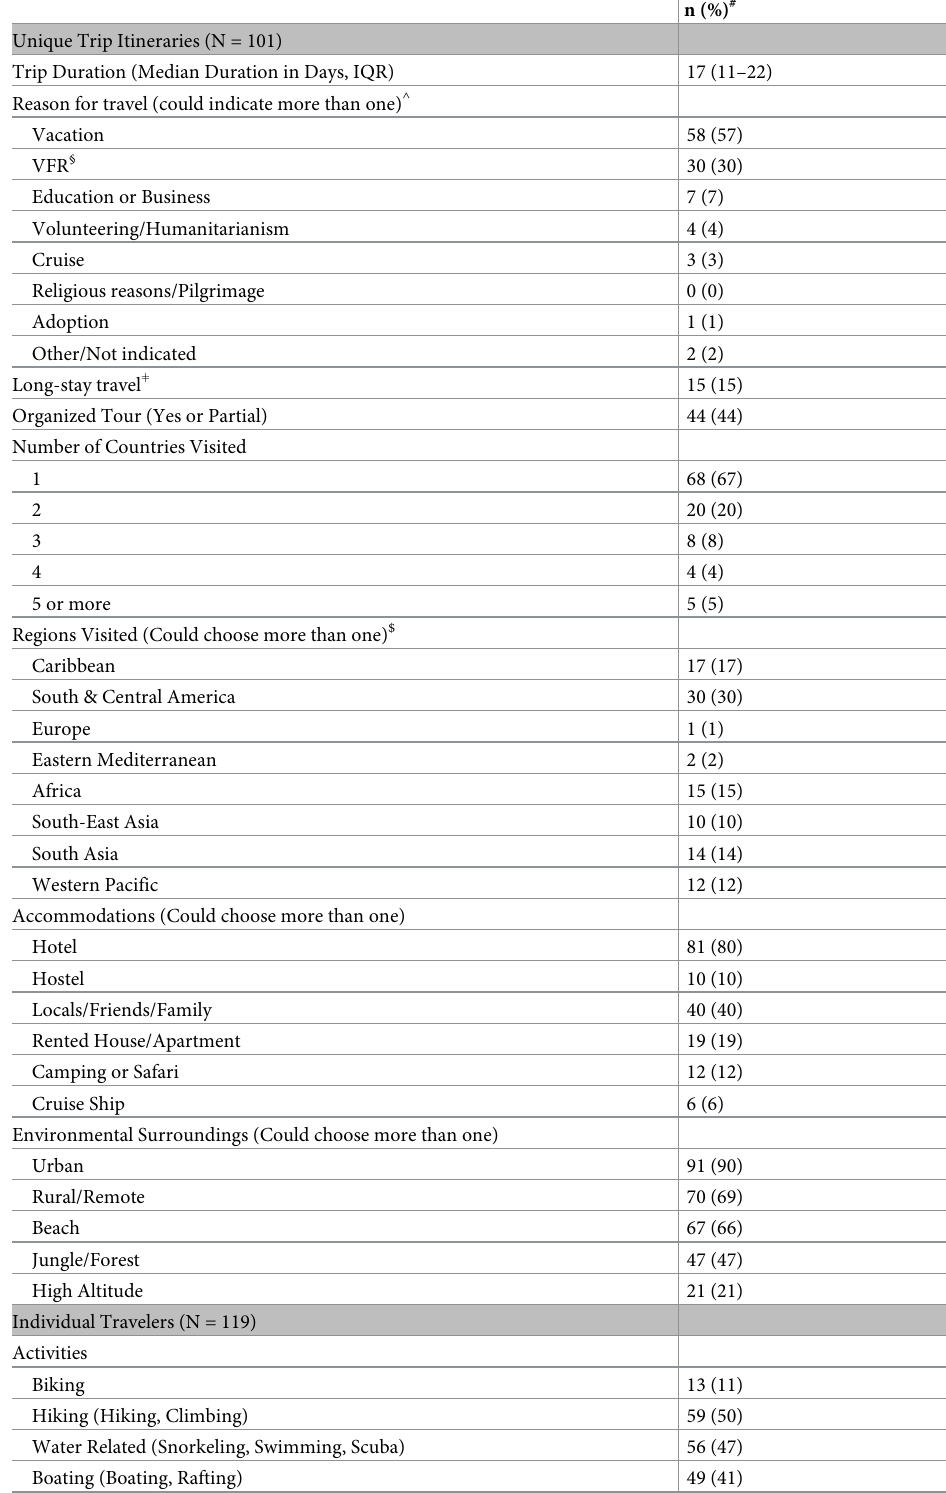
Table 3. Completed trip